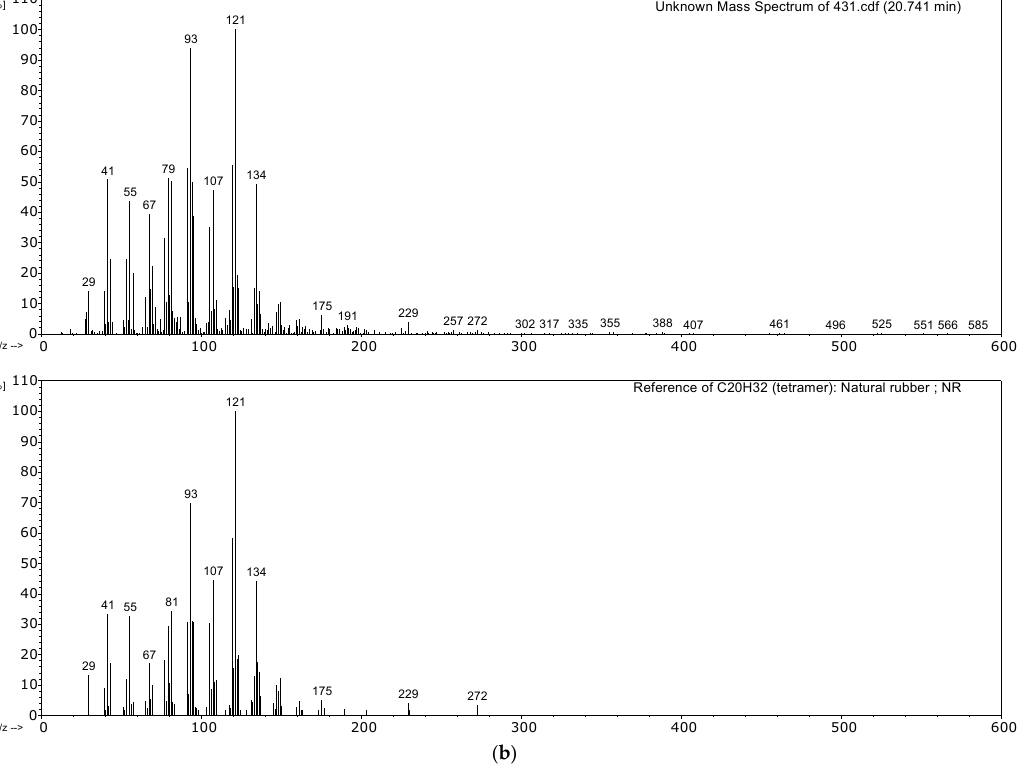
Figure 9. Mass spectra of some of ( a ) the trimers (15.48 min) and ( b ) tetramers (20.74 min) found, along with reference spectra (F ‐ Search database). The py ‐ GCMS analysis of sample 383 (Figure 10) allowed to confirm SBR as the main polymeric component, based on the main peaks at 6.76 min (styrene), 2.15 min (1,3 ‐ buta ‐ diene; probably coeluting with butene), 2.00 (propene) and 4.66 min (toluene). Further diagnostic pyrolysis products are 4 ‐ vinylcyclohexene at 5.76 min (Figure 11), xylene at 6.24 min, propylbenzene at 7.87 min, α‐ methylstyrene at 8.35 min, cyclopentadiene at 2.52 min, benzene at 3.34 min, biphenyl at 14.49 min and, particularly, the compound at 11.22 min, which has been described as a butadiene trimer (see mass spectrum in Figure 12) and a peak at 13.84 min, which coud be adscribed to 4 ‐ phenylcyclohexene, an SB (styrene ‐ butadiene) hybrid dimer (Figure 13) (Tsuge book; Kusch, 2017). A peak corresponding to sulphur dioxide could be well recognised at 2.10 min. Further, smaller peaks could be at 12.30 min, probably appears as a pyrolysis product of a sulphur ‐ containing additive